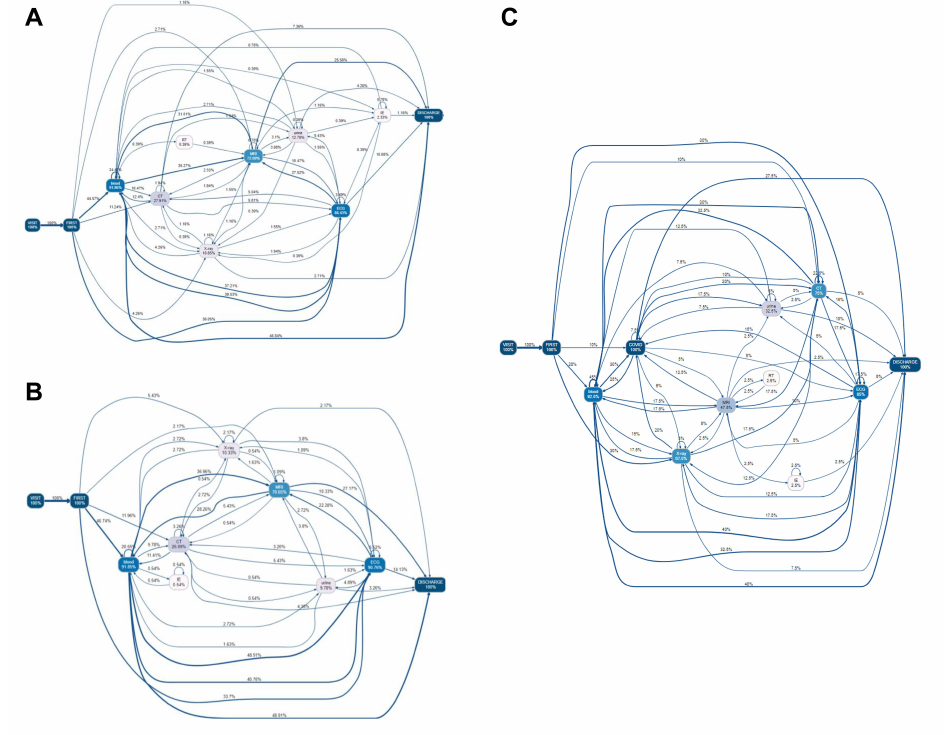
Figure 4. Process changes in patients with acute cerebrovascular disease before and after the COVID-19 pandemic. The top 65% of the process flow is shown in the figure. The arrow indicates process progression. The number above the line indicates the percentage of patients who followed the previous process to the process where the arrow points (%).Visit: time of the first visit to the ED; First: triage; IE: interventions and endoscopy; COVID-19: coronavirus disease; PCR: polymerase chain reaction; RT: nasal and sputum sample-based respiratory test; ECG: electrocardiography; Blood: blood sample-based laboratory tests; CT: computed tomography; discharge: time when the discharge order or the admission order was given. ( A ) Phase 1, ( B ) Phase 2-CTG, ( C ) Phase 2-CNTG.